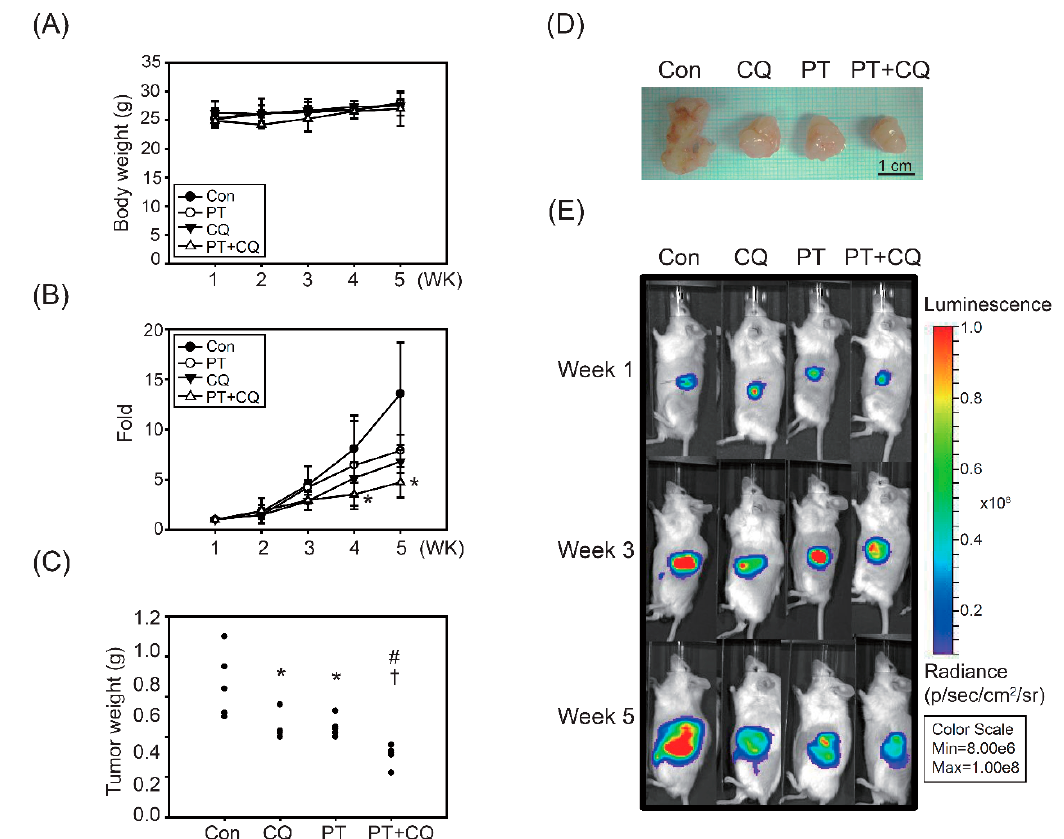
Figure 5. Combination of PT and CQ treatment enhances anticancer effects in the orthotopic pancreatic cancer model. MIA PaCa-2-Luc cells with luciferase activity were injected into the pancreas and administered with CQ (10 mg/kg) or PT (500 mg/kg)—alone or in combination—for 28 days. ( A ) Body weight in SCID mice was measured once per week. ( B ) Quantitative analysis of bioluminescence photon counts, as a measure of tumor growth throughout the entire experiment. * p < 0.05, compared to the control groups. ( C , D ) Measurement of tumor weight of orthotopic SCID mice after euthanasia. Data are presented as the mean ± SD ( n = 5 mice/group). * p < 0.05 compared to the control groups; # p < 0.05 compared to the CQ treatment groups; † p < 0.05 compared to the PT treatment groups. Scale bar = 1 cm. ( E ) Quantification of tumor burden by measuring luciferase in the pancreas. Direct observation of SCID mice with tumors via in vivo imaging of luciferase activity in the pancreas.